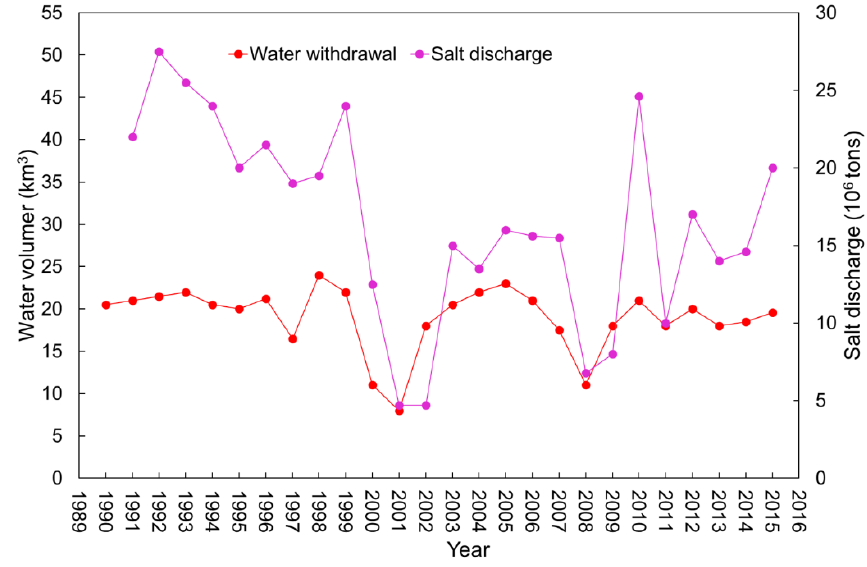
Figure 14. Annual changes in the water withdrawal and salt discharge in the ADD from 1990 to